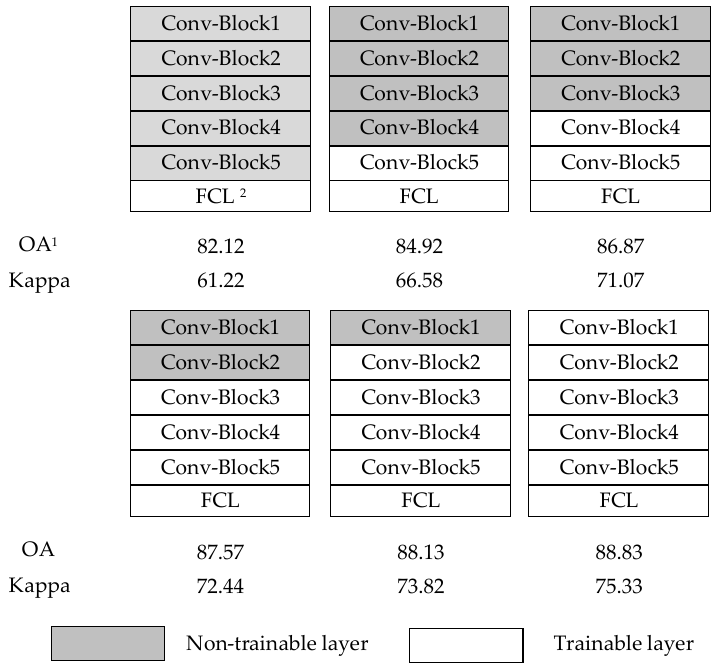
8 of 12 Figure 4. Performance of dataset augmentation. ( A ) Loss curves. ( B ) Time consumption for training the model. 4.3. Effect of Fine-Tuning Different Layers for the Detecting Collapsed Buildings The comparison between incremental fine-tuning was applied to investigate the impact of the depth of fine-tuning on the performance of pretrained VGGNet model with dataset enlarged by 16 times (16×). The results were shown in Figure 5. It is obvious that the performance of pretrained VGGNet model increases with the increased of fine-tuned convolutional blocks. The worst result was